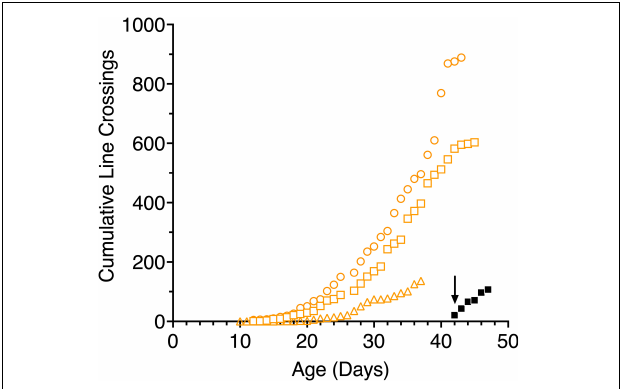
FIGURE 4 | Cumulative line crossings obtained from 5-min trials of 3 light-exposed (open orange symbols: C117 squares, C118 circles, C119 triangles) and a representative dark-reared kitten (C116, filled black symbols) as a function of age. The arrow indicates when the dark reared kitten was first exposed to an illuminated environment.